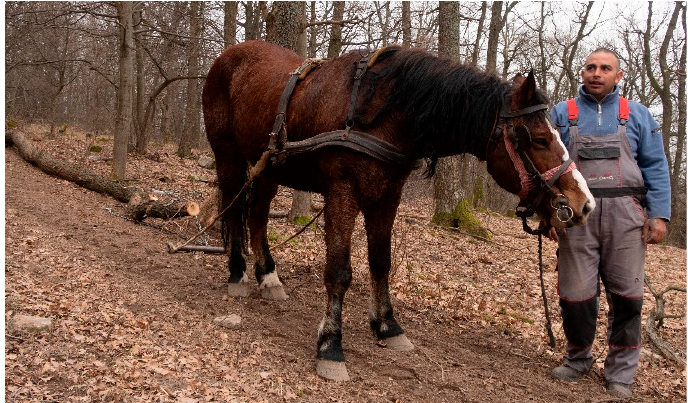
Figure 1. One horse in work with a chain, led from the front (area of the Tállya Forest District, 2021).